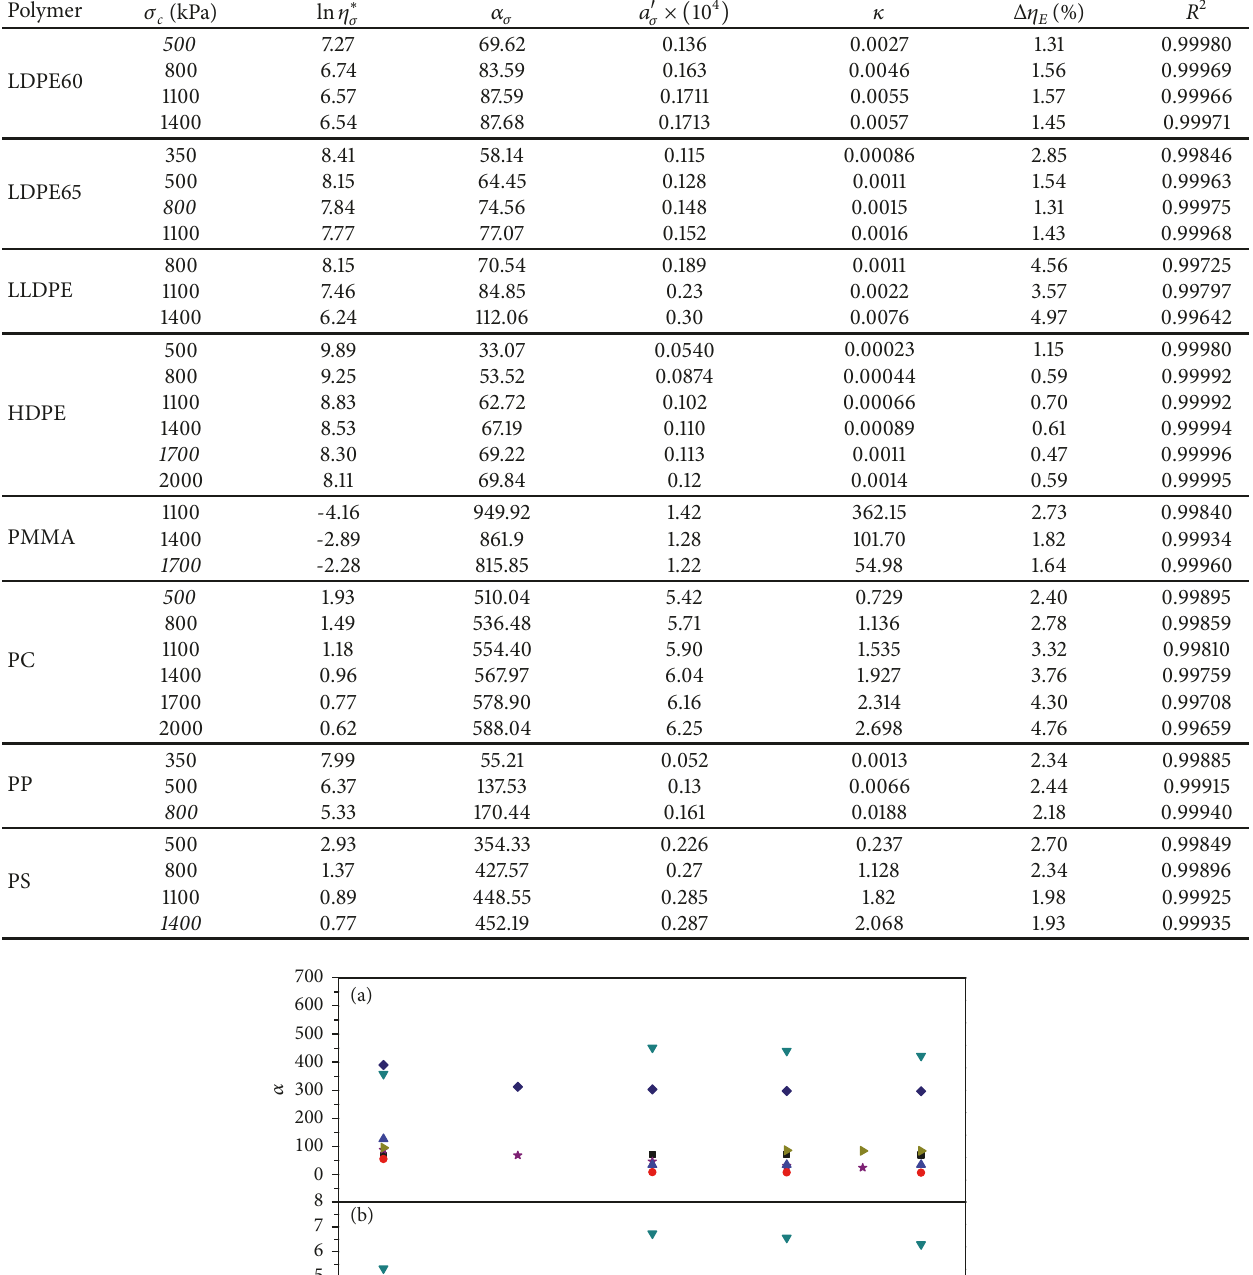
Table 4: Values of parameters of (7) evaluated for 𝜂 𝐸 at different elongational stresses. Polymer